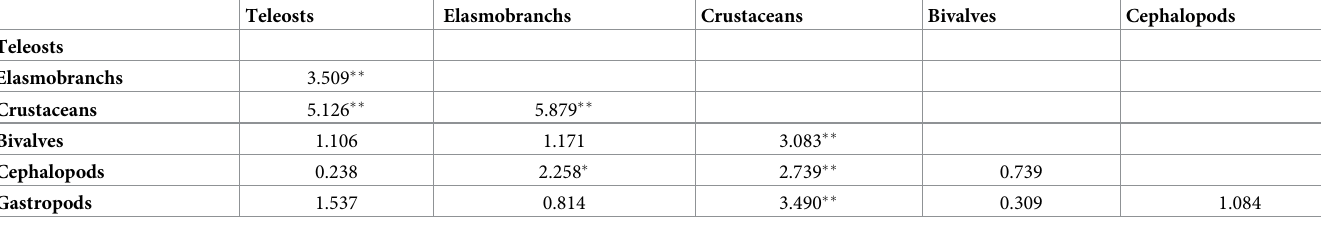
Table 5. Pairwise mean comparison of Student t-statistic of IRV scores of 6 groups of 133 species